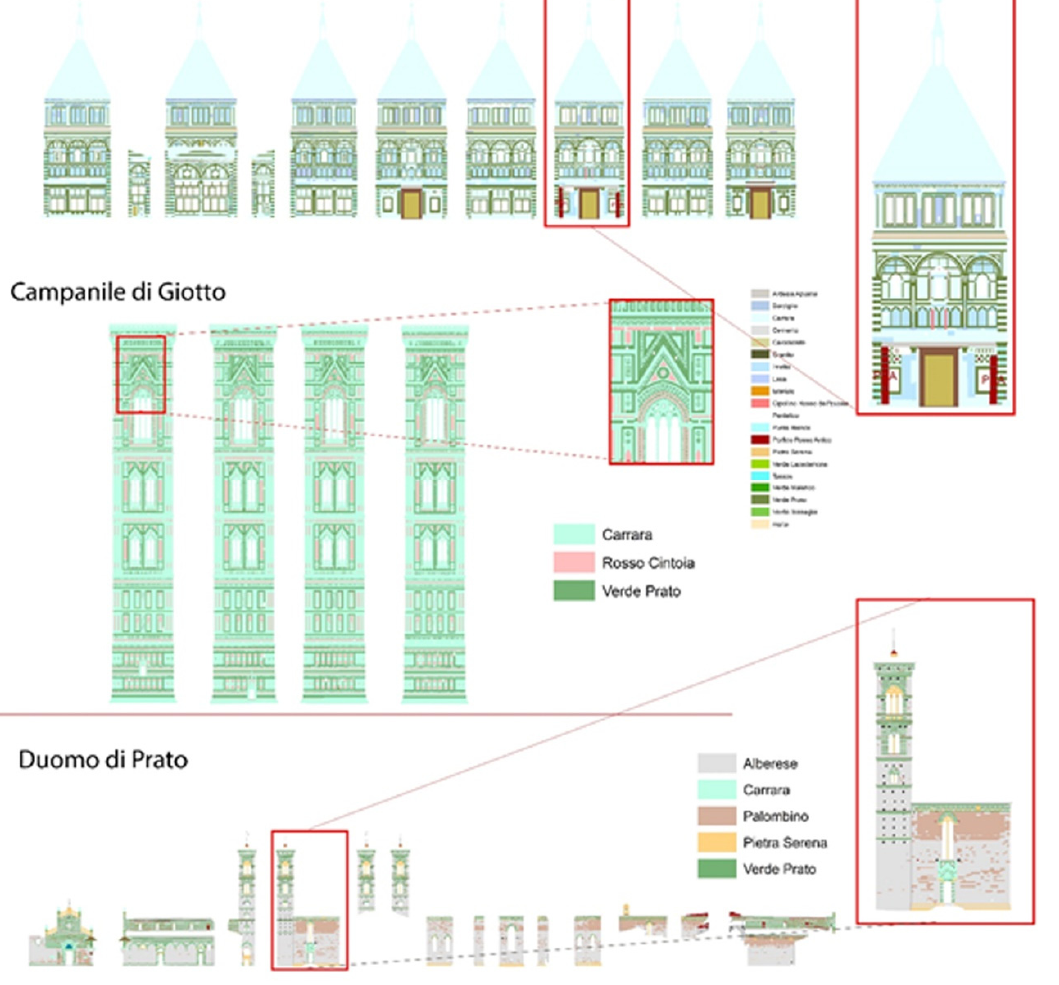
Figure 9. Monument “Lithological Figure 9. Monument "Lithological map" .